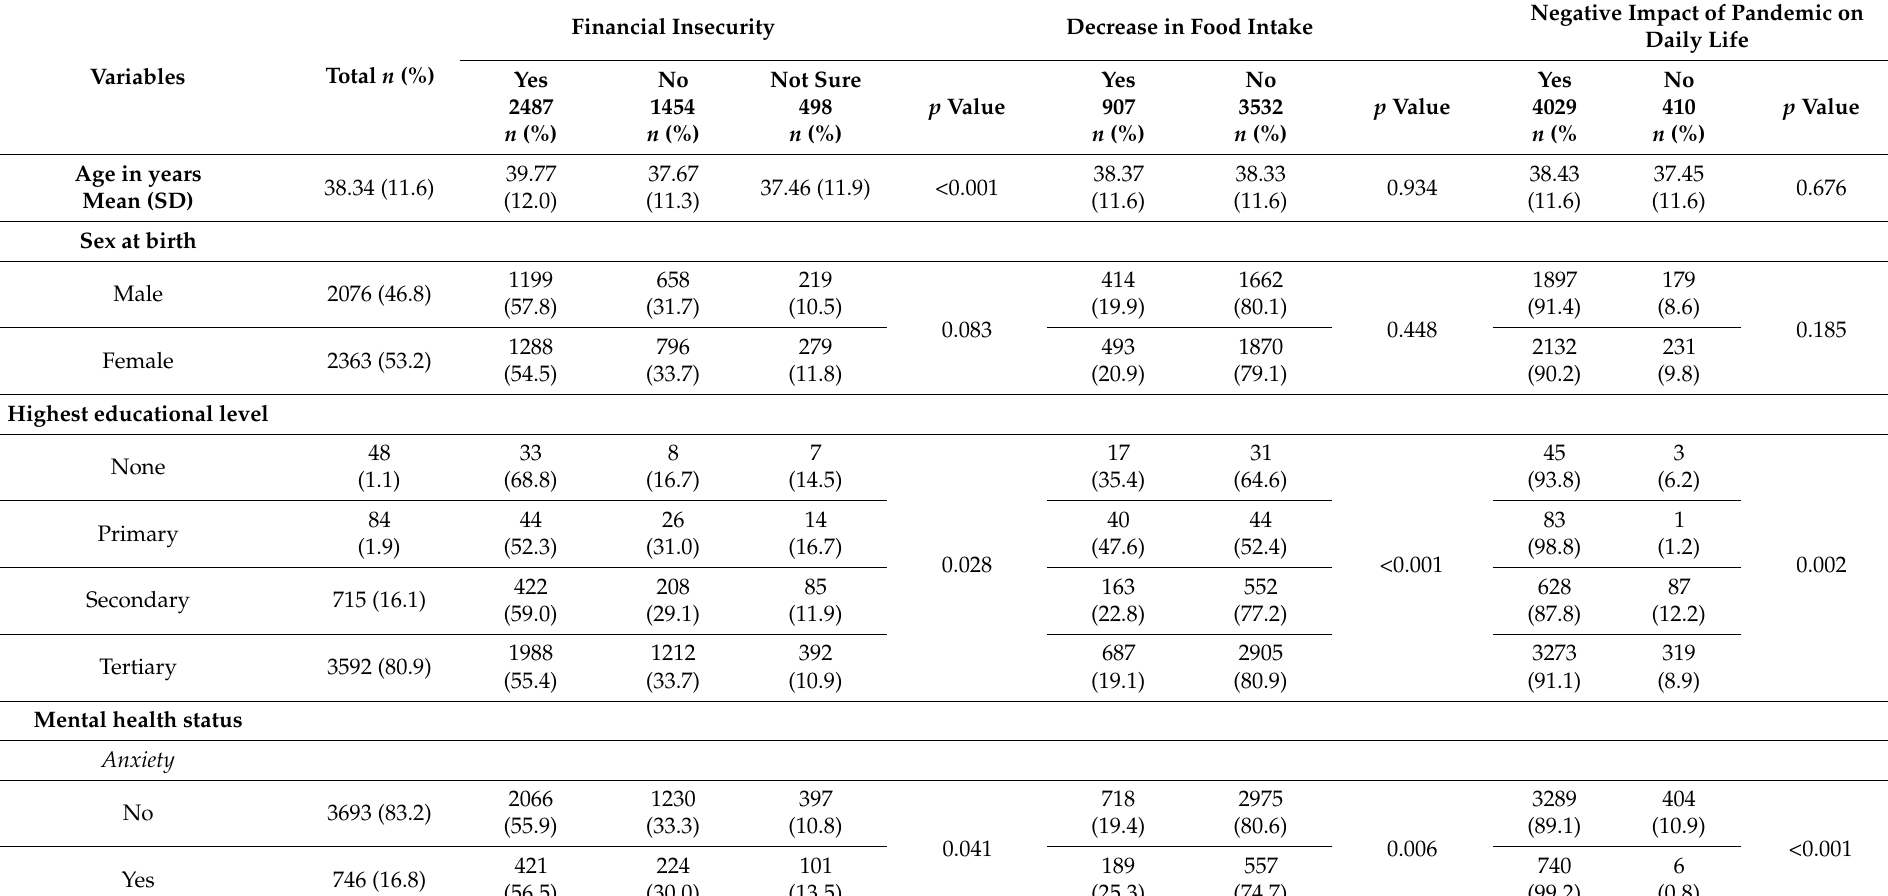
Negative Impact of Pandemic on Daily